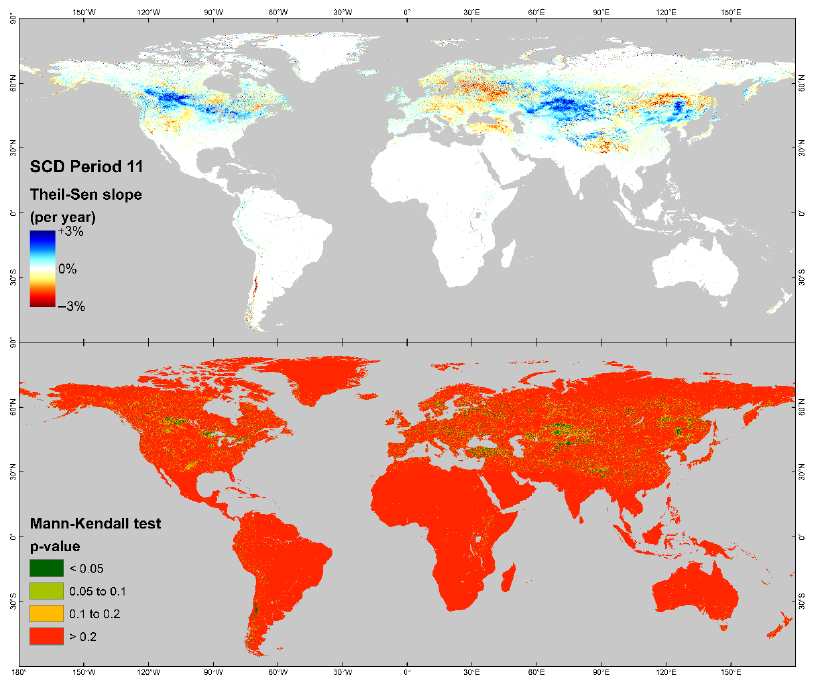
Figure 8. Pixel-based development of SCD in November. The Theil–Sen slope is shown above and the associated p -values are shown below. the associated p -values are shown